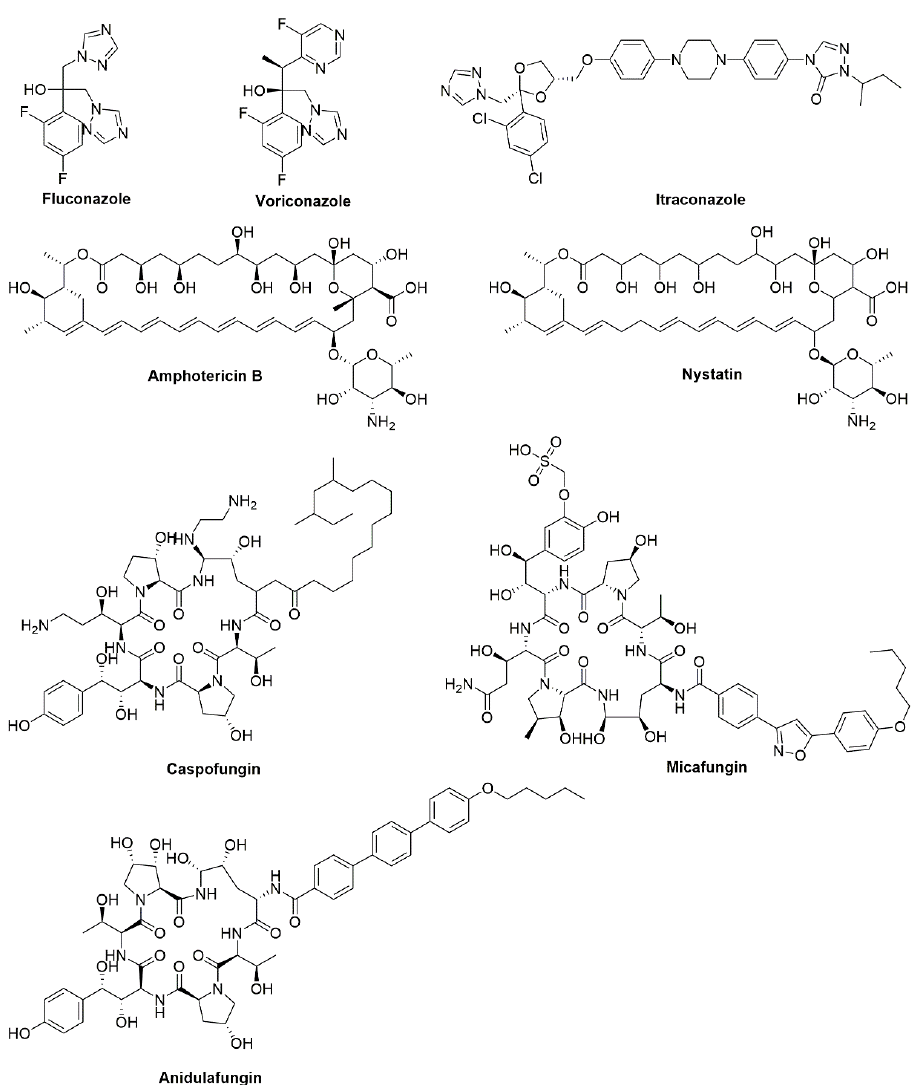
Figure 1. Chemical structures of traditional antifungal agents acting on C. albicans . Table 1. The effects of traditional antifungal agents on C. albicans . Table 2. The effects of natural products on C. albicans virulence